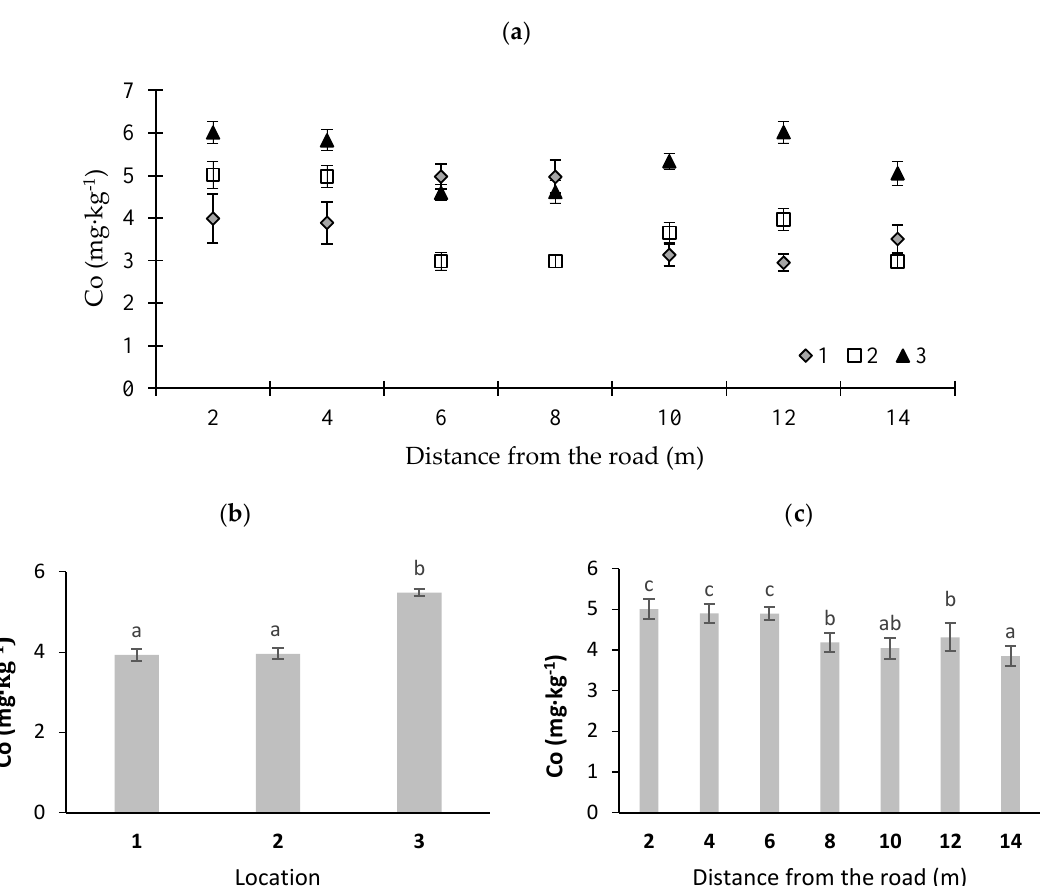
Figure 5. Cobalt concentrations in moss ( P. schreberi ): ( a ) distance from the road at sampling location, ( b ) average Co content at di ff erent locations, and ( c ) Co content at di ff erent distances from the road (average values from three locations) ( n = 5, ± standard deviation). Di ff erent letters above bars representing lead concentrations for di ff erent locations or for di ff erent distances from the road indicate that they di ff ered significantly (Tukey’s test, p < 0.01).